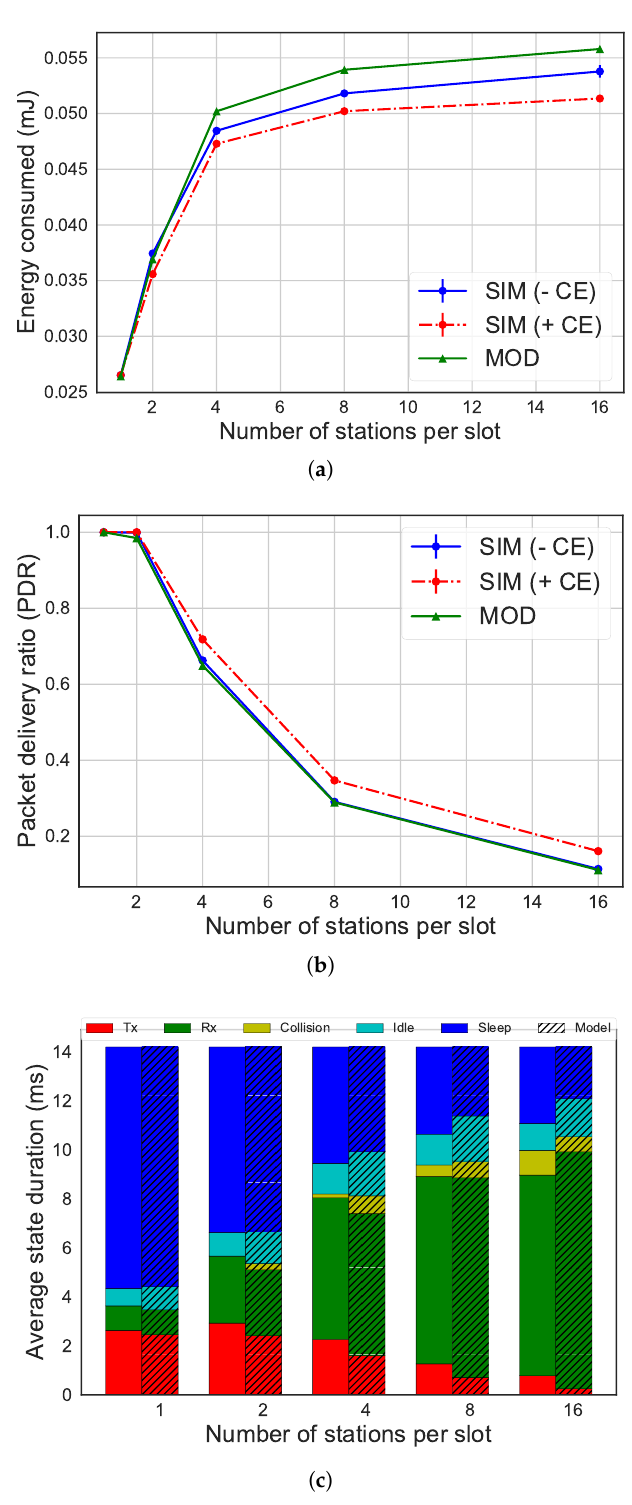
Figure 4. Comparison of results between simulation without capture effect (CE) (simulation (SIM) − CE) and with CE (SIM + CE) and analytical model (MOD) for 300 kbps, 16 bytes as payload size and 16,384 µ s as slot duration. ( a ) average energy consumption per STA; ( b ) packet delivery ratio (PDR); ( c ) radio state duration per station